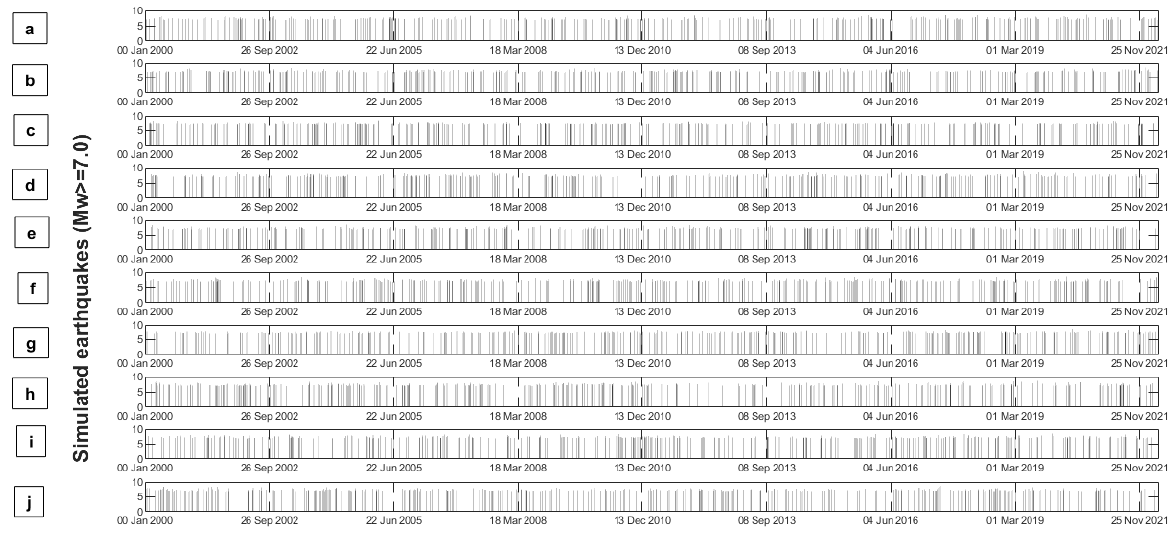
Figure 6. Panels ( a – j ) show an array of the first 10 simulated earthquakes dataset (out of 100 simulations) during the period of 1 January 2000 and 28 April 2022.